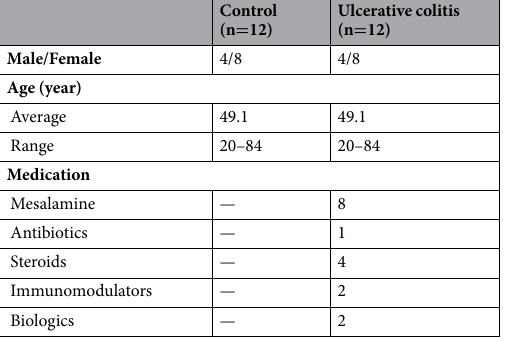
Table 1. Characteristics of patients with active UC and